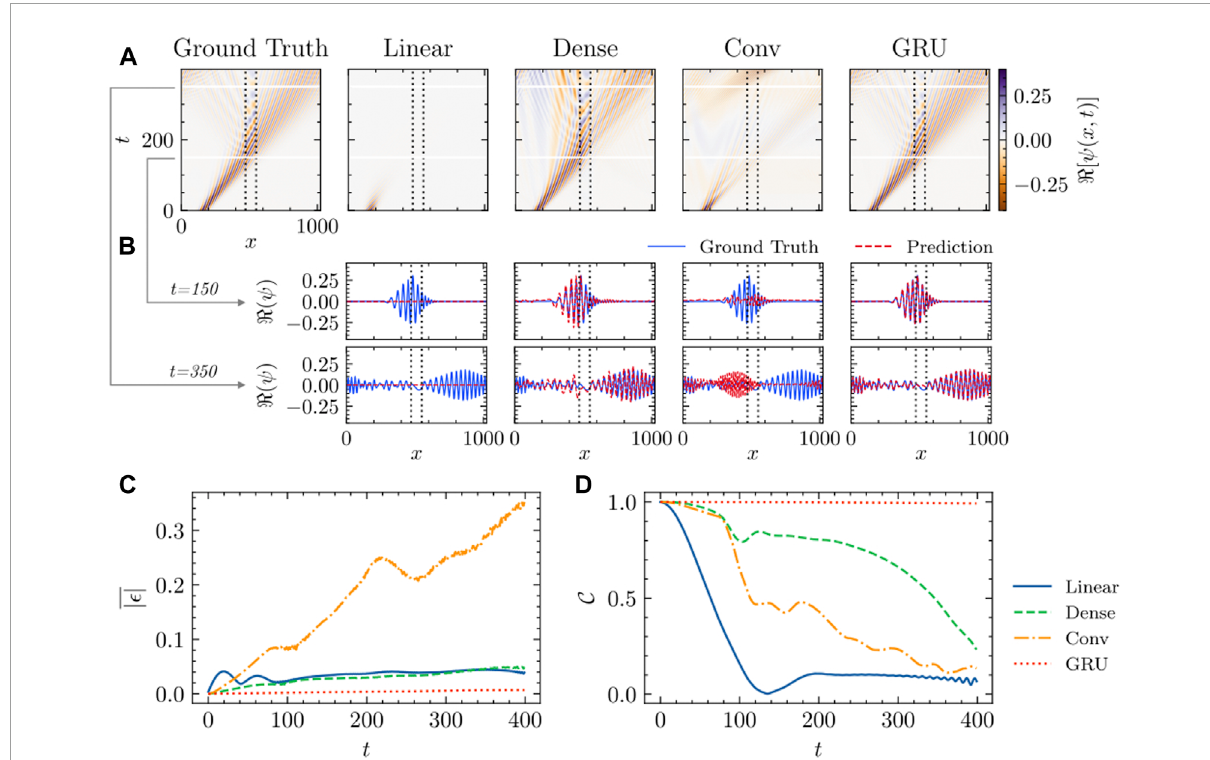
FIGURE 5 Scattering of a Quantum Wave Packet by a Rectangular Potential Barrier. (A) , Ground truth and the predicted value of R [ ψ ( x , t )] for quantum wave packets scattered by a rectangular potential barrier. (B) , Comparisons of emulated and exact solutions corresponding to two temporal snapshots (time steps 150 and 350 and depicted by the white horizontal lines in panel a ). (C,D) , Time-step-by-time-step error propagation calculated as a mean absolute error, | ϵ | (less is better), and normalized correlations, C (closer to one is better),